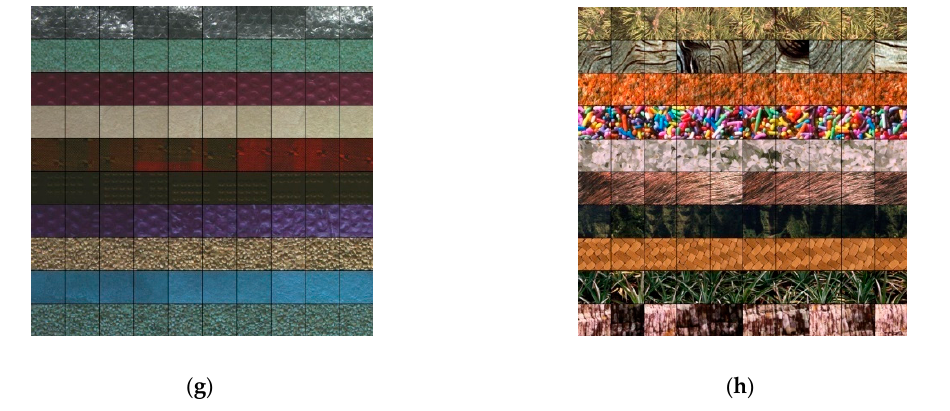
Figure 6. Some sample images from the eight databases: ( a ) Coil-100; ( b ) Face95; ( c ) Face96; ( d ) Outex-00031; ( e ) Outex-00032; ( f ) Outex-00033; ( g ) Outex-00034; and ( h ) MIT-VisTex.